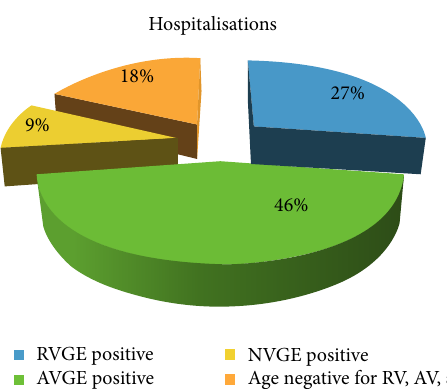
Figure 6: Comparison between hospitalisations during RVGE, AVGE, and NVGE episodes.